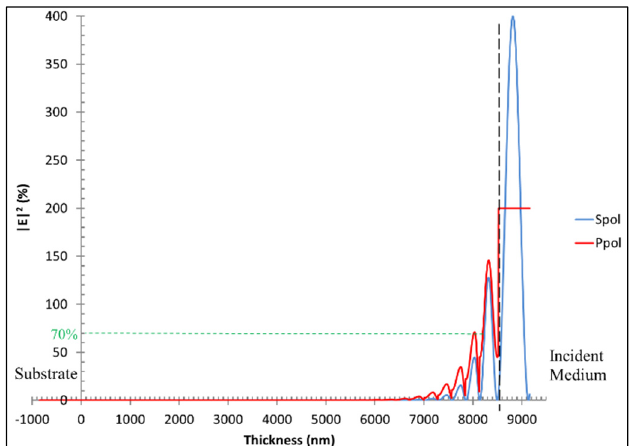
Figure 7. Optical E ‐ field intensities (as % of incident intensity) within the coating for 900 nm wavelength light at 45° AOI, Spol and Ppol, for the BBHR coating design. The vertical dashed line indicates the boundary of the coating with the incident medium. This figure appeared as the top left ‐ hand graph in Figures 6 and 8 of our earlier report [15]. Coatings 2016 , 6 , 11